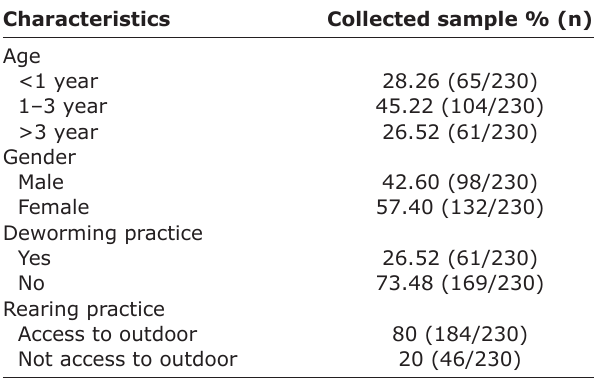
Table-2: Demographic data of sampled cats. Characteristics